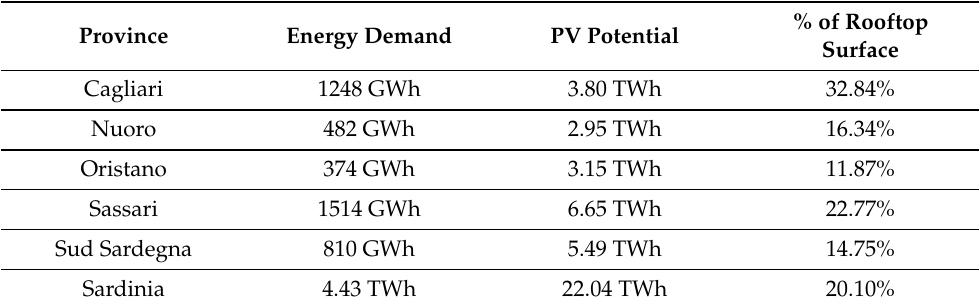
Table 2. Electricity consumption in the domestic and services sectors, and photovoltaic potential for the 5 provinces of Sardinia. The percentage indicates the fraction of eligible rooftops that, if equipped with a photovoltaic system and accumulators, would cover the needs of the domestic and services